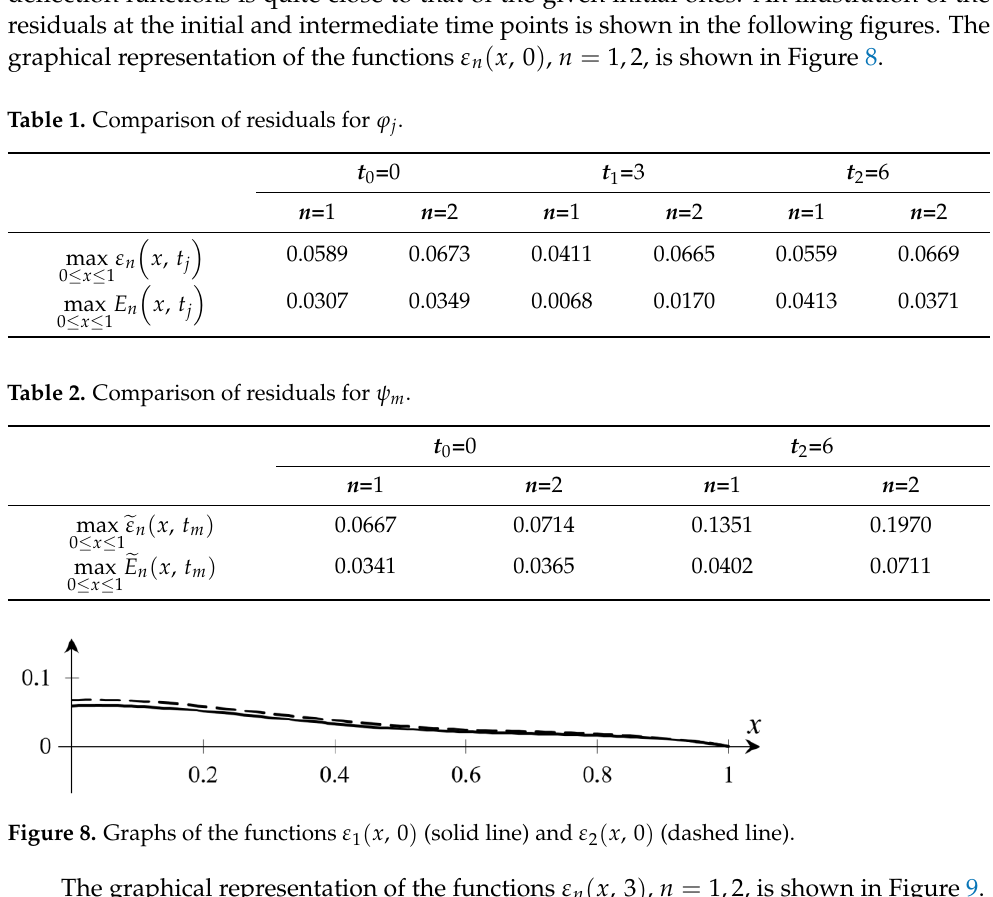
Figure 9. Graphs of the functions 𝜀 1 (𝑥, 3) (solid line) and 𝜀 2 (𝑥, 3) (dashed line). The proposed analytical constructions are valid for any first 𝑛 harmonics of string vibrations. Numerical calculations, illustrations of the results and their analysis were car- ried out with the help of the developed general approach for 𝑛 = 1,2 . The series (21) is uniformly convergent for functions from the above classes. The behavior of the functions 𝑉 1 (𝑡) and 𝑉 2 (𝑡) shows it (see Figure 2). Thus, given 𝑛 = 1 and 𝑛 = 2 , we construct explicit expressions of the boundary con- trol 𝑢 1 (𝑡) and 𝑢 2 (𝑡) and those of the string deflection functions 𝑄 1 (𝑥, 𝑡) and 𝑄 2 (𝑥, 𝑡) . 6. Conclusions We proposed a constructive method for constructing the control of vibrations of a homogeneous string with a given deflection shape at an intermediate moment. We also proposed a constructive method for constructing the control of homogeneous string vi- brations with a given deflection shape at an intermediate moment. The control was carried out by shifting one end with the other end fixed. The construction scheme was as follows: We reduced the original problem to the control problem of distributed influences with zero boundary conditions. Further, we used the method of separation of variables and methods of control theory for finite-dimensional systems with multipoint intermediate conditions. We formulated the corresponding statement and theorem for the first 𝑛 harmonics. A specific example illustrated the obtained results. We realized a computational experi- ment, constructed the corresponding graphs and made a comparative analysis. They con- firm the results of the study. The proposed method can be extended to other non-one- dimensional vibrational systems. The results presented in the paper can be used in the design of boundary control of vibration processes in physical and technological systems. Author Contributions: Conceptualization, V.B. and S.S.; methodology, V.B.; software, S.S.; valida- tion, V.B. and S.S.; formal analysis, V.B. and S.S.; investigation, V.B. and S.S.; resources, V.B. and S.S.; data curation, S.S.; writing — original draft preparation, V.B. and S.S.; writing — review and ed- iting, V.B. and S.S.; visualization, S.S.; supervision, V.B. and S.S.; project administration, V.B. and S.S.; funding acquisition, V.B. and S.S. All authors have read and agreed to the published version of the manuscript. Funding: Part of the research of S.S. was carried out under State Assignment Project no. FWEU- 2021- 0006, reg. number АААА - А21 -121012090034-3, of the Fundamental Research Program of Rus- sian Federation 2021 – 2030 using the resources of the High-Temperature Circuit Multi-Access Re- search Center (Ministry of Science and Higher Education of the Russian Federation, project no 13.CKP.21.0038). Institutional Review Board Statement: Not applicable.